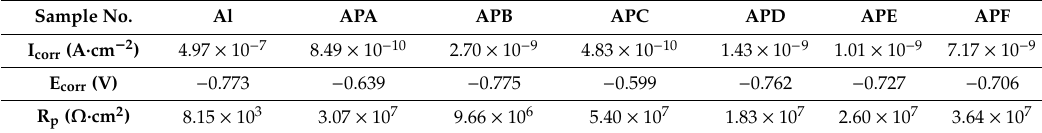
Table 4. Corrosion properties of pure aluminum and PEO coatings.